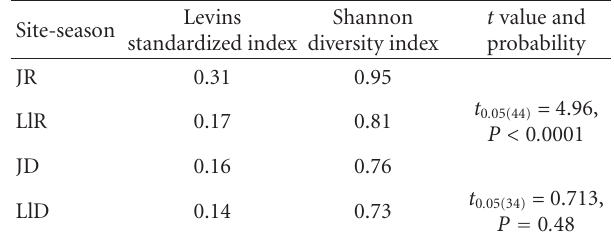
Table 1: Results of two-way ANOVA test for the e ff ect of site, season and interaction on the foragingintensity of Pogonomyrmex barbatus at the “Helia Bravo” Botanical Garden, Puebla, Mexico. Significant level α = 0 . 05.